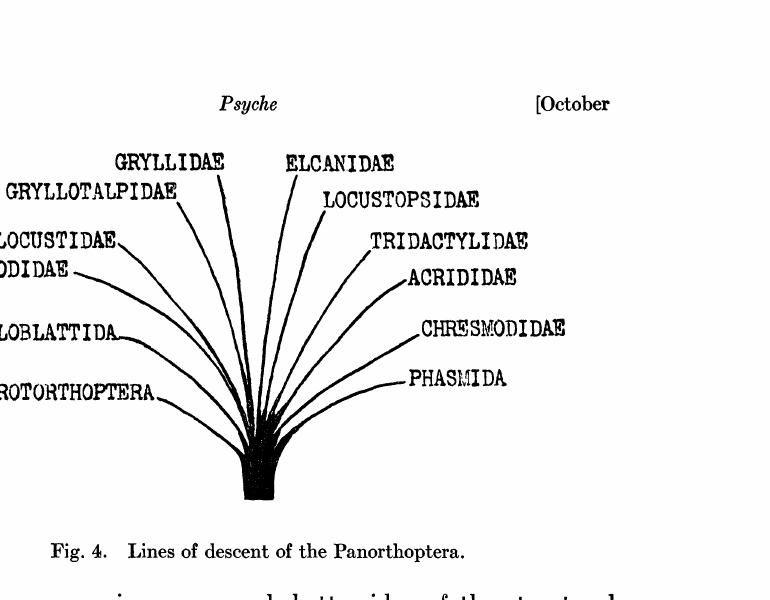
Fig. 4. Lines of descent of the